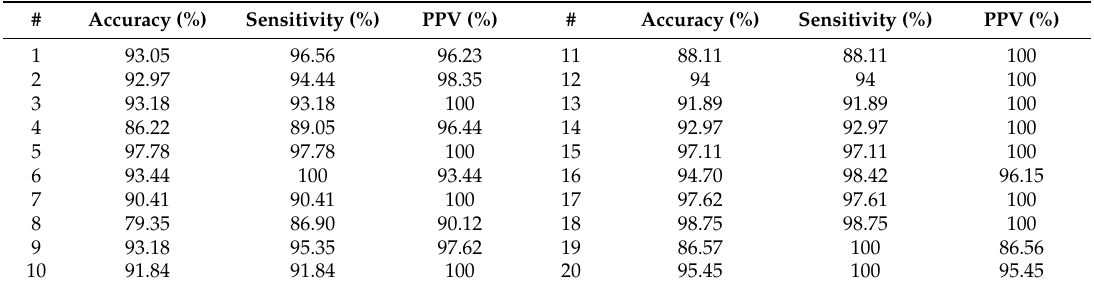
Table 1. Accuracy, Sensitivity, and Positive Predictive Value (PPV) results for the fat region detection.